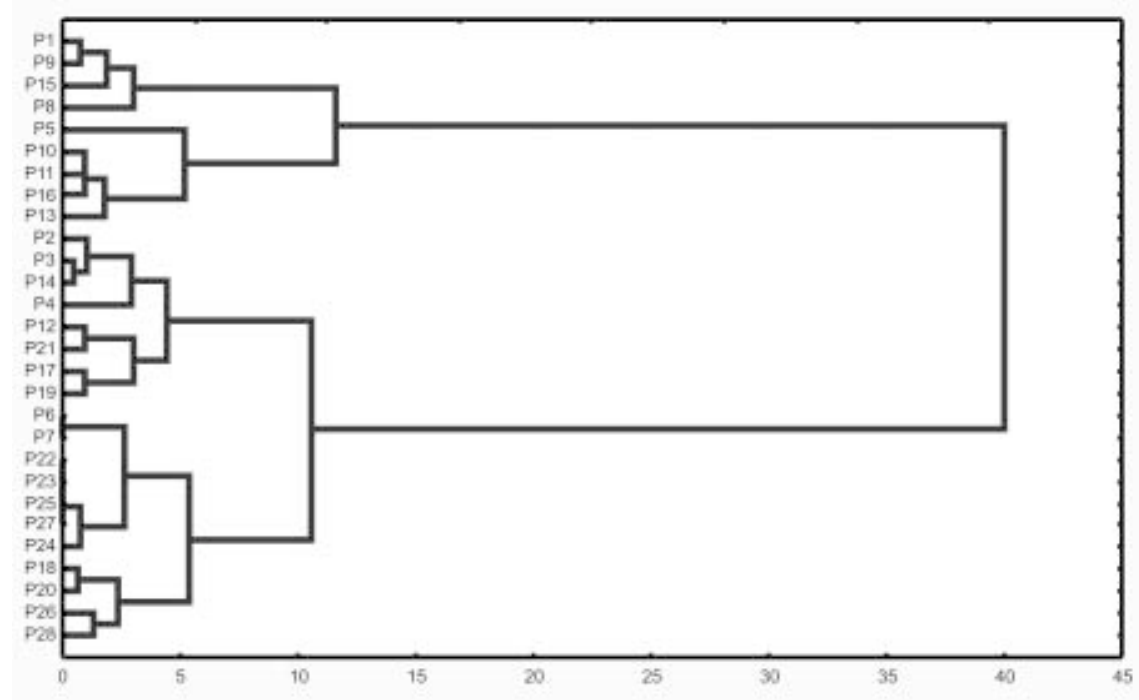
Fig 1 . A dendrogram tree based on Ward(cid:146)s method, all criteria applied Source: [12, p. 315] Table 2. Classification of strategic planning